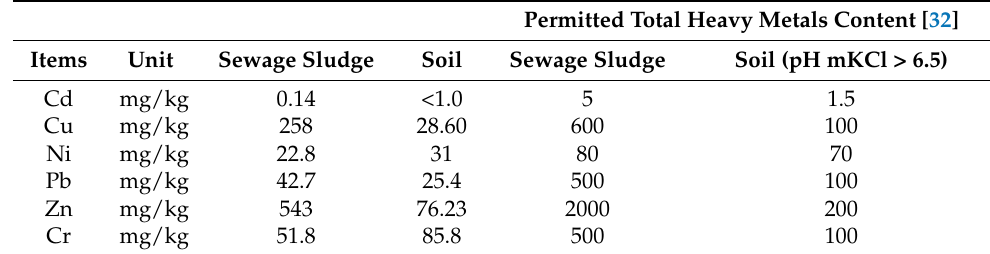
Table 2. Sewage sludge used in accordance with the values prescribed by Croatian